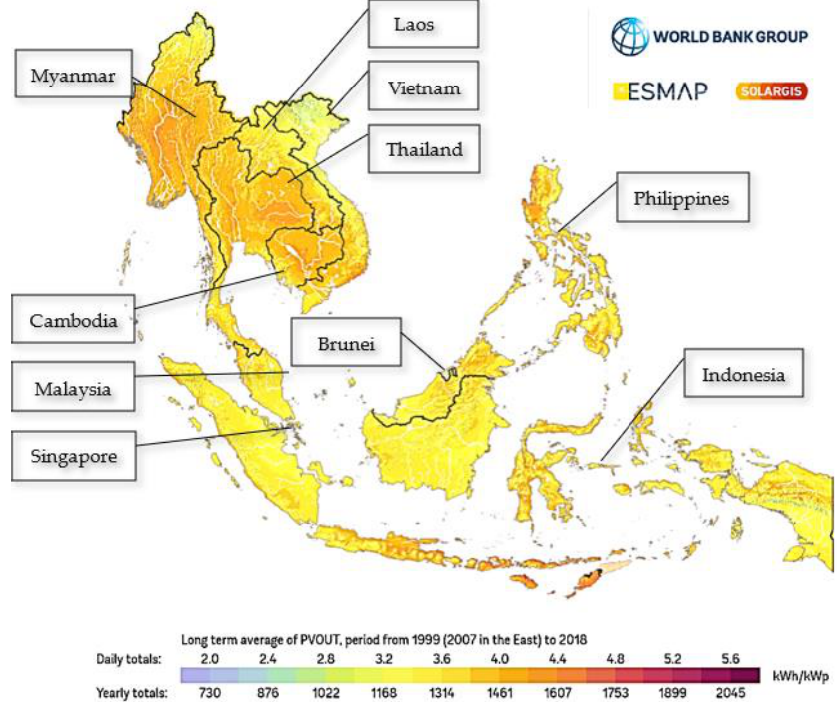
Figure 3. Solar radiation resource in the Association of Southeast Asian Nations (ASEAN) countries. Source: Global Solar Atlas 2.0, Solar resource data: Solargis. © 2019 The World Bank. Table 3. Land resource comparative advantage of the Association of Southeast Asian Nations (ASEAN) compared with Japan and India.